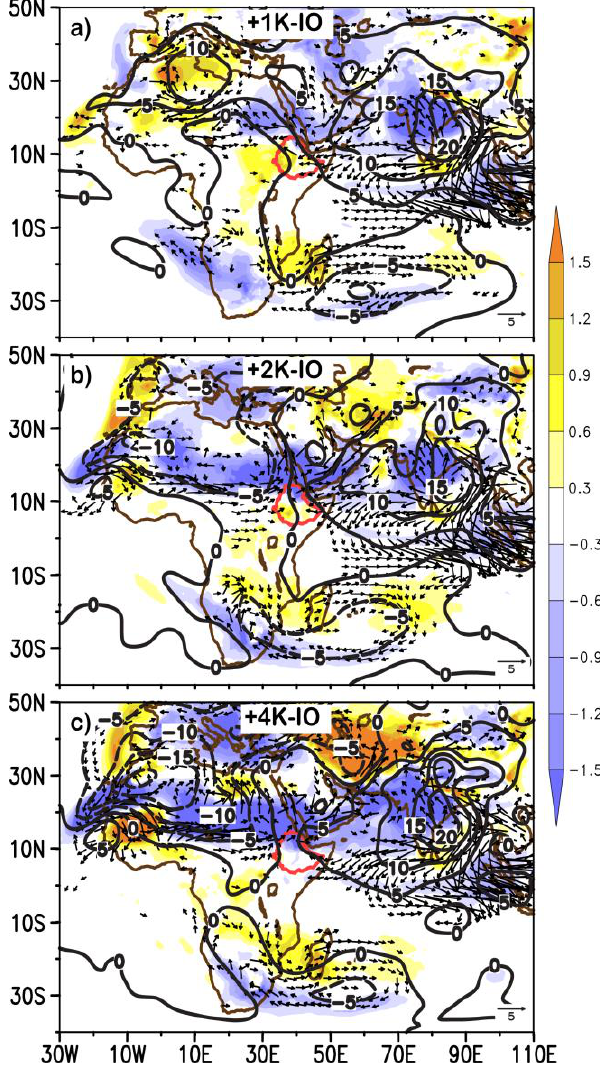
Figure 12. Circulation changes from CNTRL at 850 hPa averaged over July-August for SST anomaly (SSTA) forcing of ( a ) +1K, ( b ) +2K, and ( c ) +4K over the Indian Ocean (IO; 40°S–25°N, 30°–110°E). Each panel shows differences in horizontal winds (vectors; m·s −1 , magnitude scale in lower right corner), temperature (shading; K, color scale at right), and geopotential height (contours; gpm) between the perturbed SSTA forcing experiments and CNTRL. Differences of geopotential heights are contoured every 5 gpm. Anomaly vectors are plotted for resultant magnitudes of at least 1 m·s −1 only. The border of Ethiopia is delineated in solid red line. See Table 1 for description of